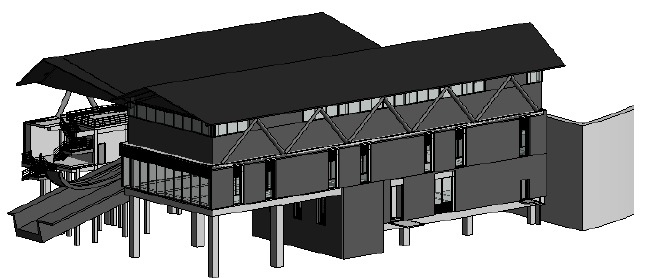
Figure 12. BIM model for a building in the bobsleigh and sled stadium.